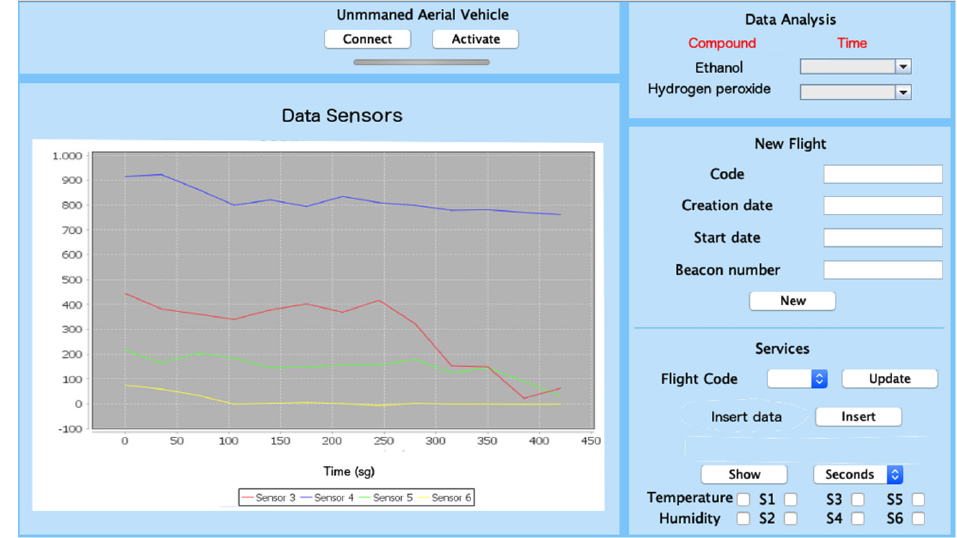
Figure 6. Developed JAVA application.